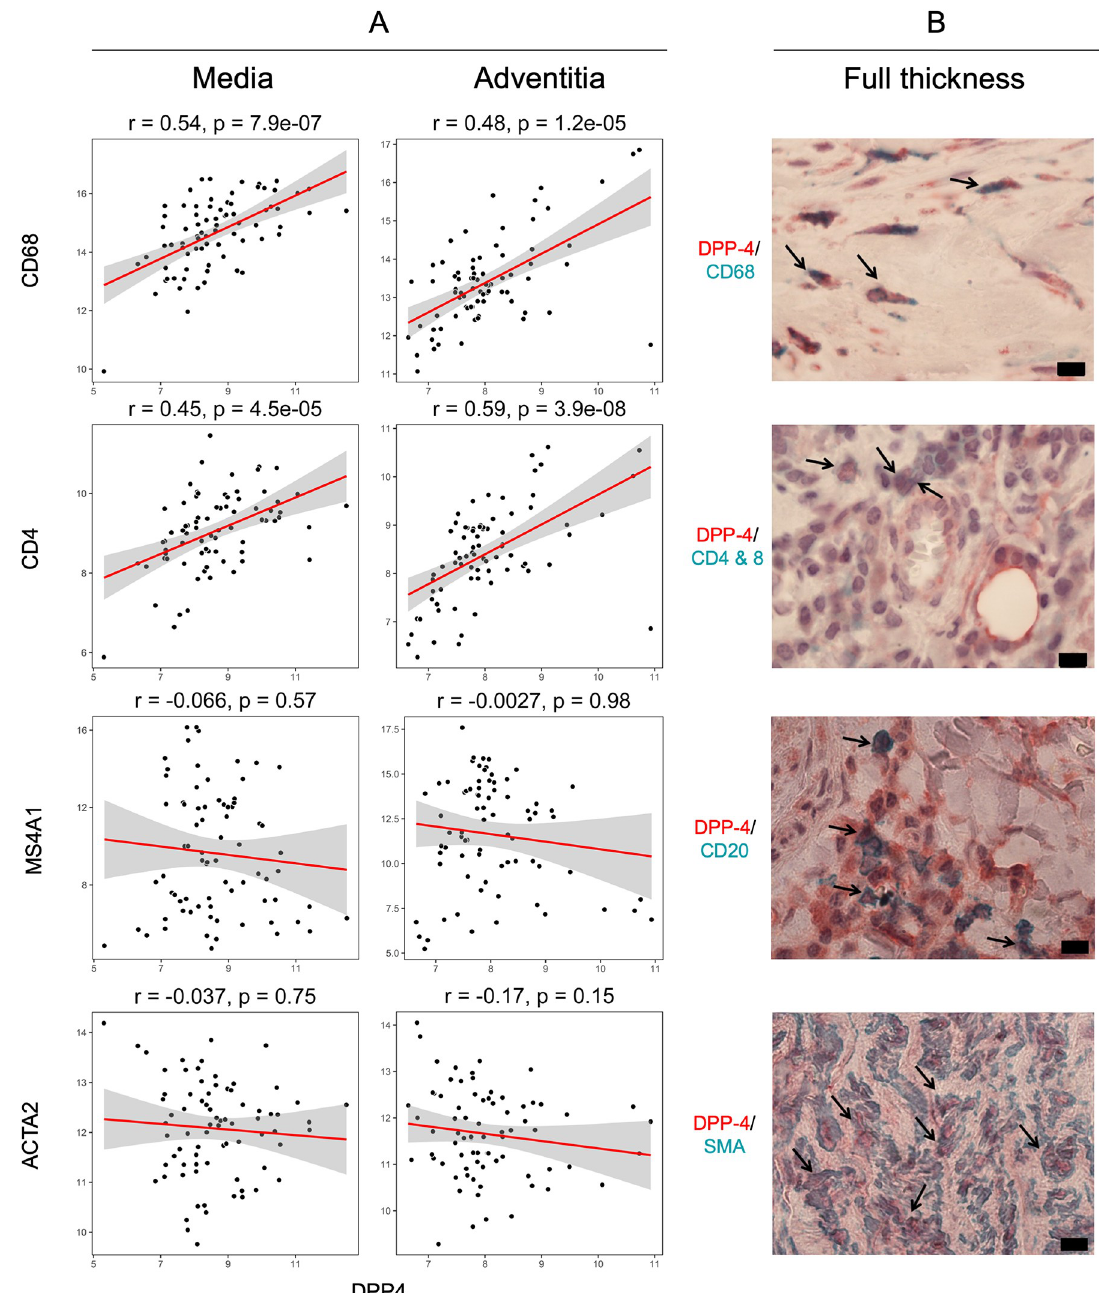
Fig 3. Correlation and co-localization of DPP4 gene and protein with leukocyte and smooth muscle cell-markers in the aneurysm wall. A: Spearman correlation between the expression of DPP4 and CD68, CD4, MS4A1 and ACTA2, as approximate markers for macrophages, CD4+ T-cells, B-cells and smooth muscle cells. B: Immunohistochemichal double staining to between DPP4 and CD68, CD4&8, CD20 and SMA as markers for above cell types. Arrows indicate co-localization.